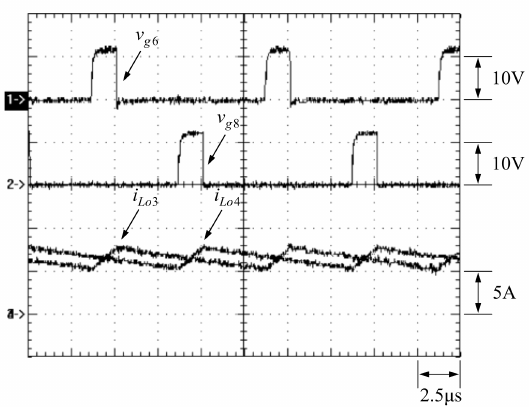
Figure 19. Two-phase inductor currents at rated load for the second secondary output.